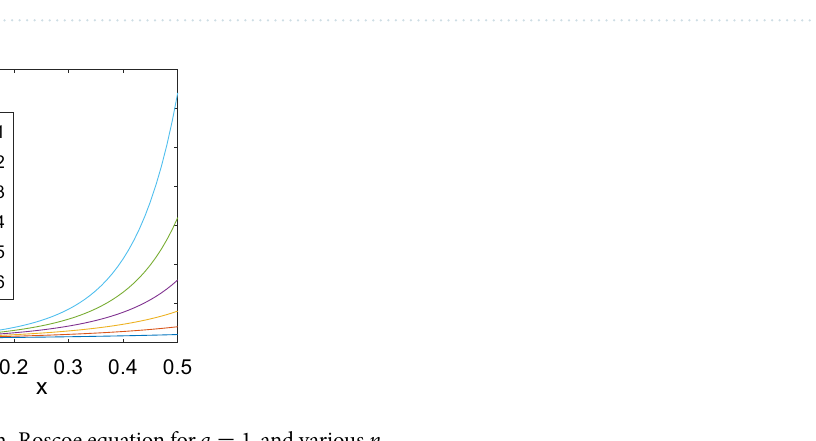
Figure 5. Prediction results of the coefficient n of Einstein–Roscoe equation. A plot with circles lying closer to the diagonal represents better prediction performance, and the predictions with smaller prediction intervals (vertical bar) represents higher confidence in the prediction. Customized kernel with optimized parameters (right most) not only achieved the best prediction performance, but displayed the higher confidence in the prediction than the other kernels.